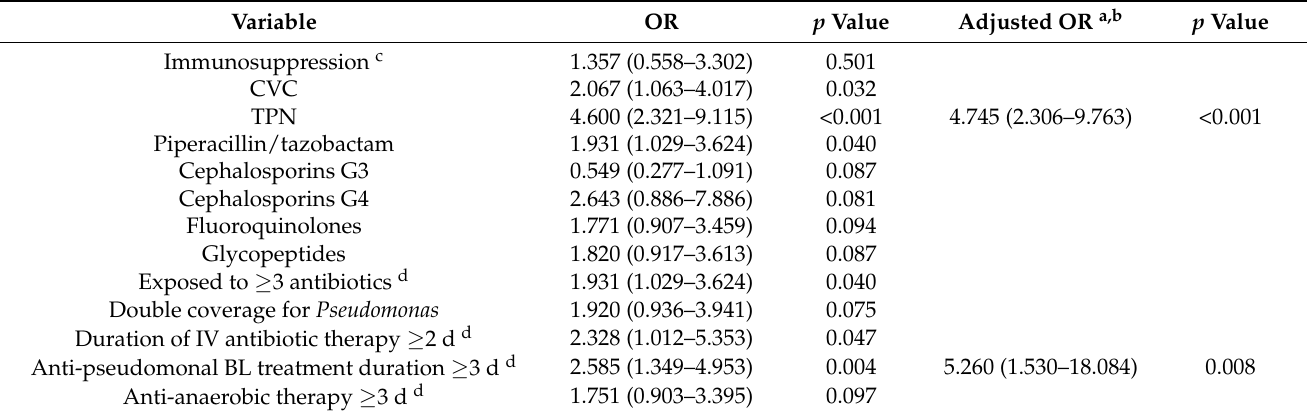
Table 4. Univariable and multivariable logistic regression analyses in the non-CRBSI population.